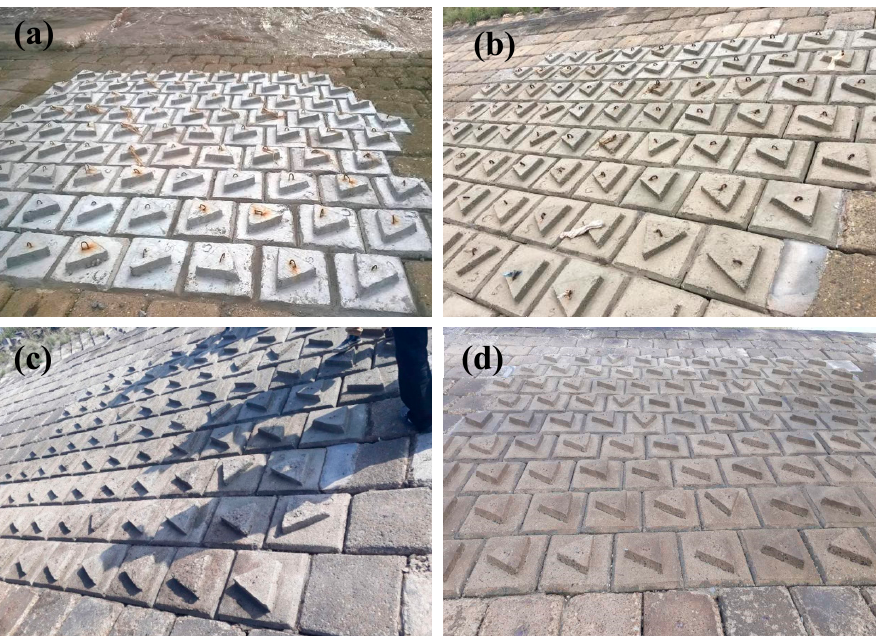
Figure 7. Field test: ( a ) after setting, ( b ) after 2 years, ( c ) after 3 years, and ( d ) after 4 years.